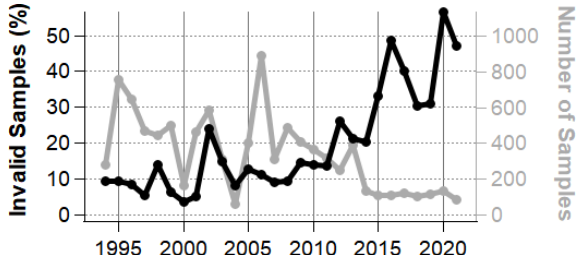
Figure 4. Annual percentage of cloud water samples considered invalid according to ion balance criteria [invalid / (invalid + valid)] (black, left axis) and total number of samples (valid + invalid + unclassified) in each year (grey, right